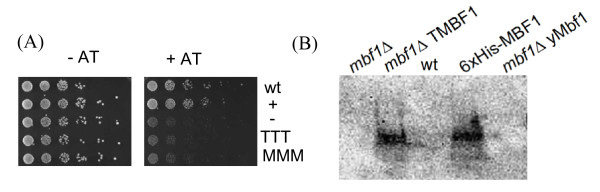
Functional complementation of yeast mbf1Δ by archaeal MBF1 from T. tenax (T) and M. mazei (M). (A) AT sensitivity of yeast wild type (WT), the mbf1Δ strain carrying pyMBF1 (+), empty vector (-), pTMBF1 (TTT) and pMMBF1 (MMM) using the vector pRS316 under control of the natural yeast MBF1 regulatory region. Serial dilutions of the respective strains were placed on minimal medium either in the presence (+AT) or absence (-AT) of 3 mM aminotriazole. The plates were incubated at 30°C for 3 days. (B) Expression of TMBF1 protein (pHRTMBF1) in the ymbf1Δ strain was detected by immuno blotting using a polyclonal antibody against TMBF1.